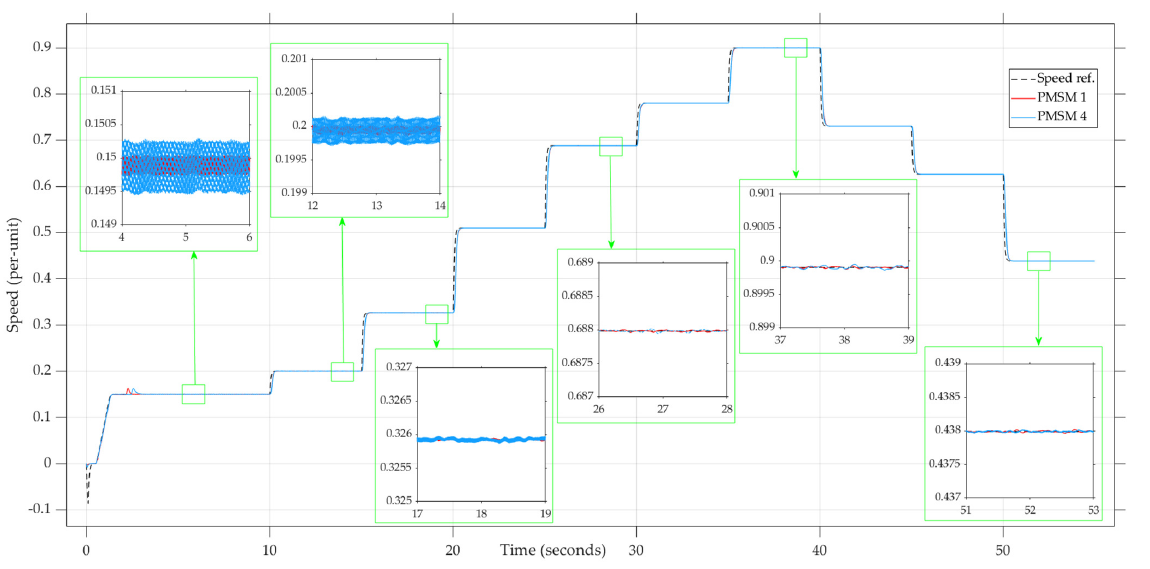
Figure 13. Simulation result for speed feedback generated by proposed observers PMSM 1 and PMSM 4.